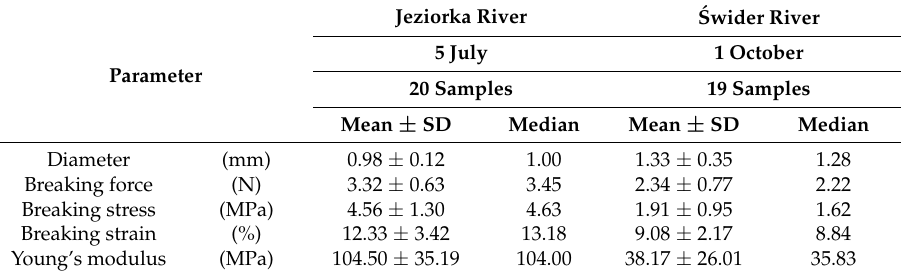
Table 6. Diameter and tension test results for P. pectinatus